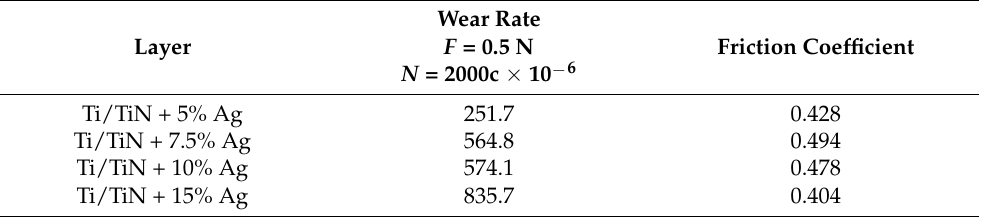
Table 1. Results of friction coefficient and wear indicator tests.